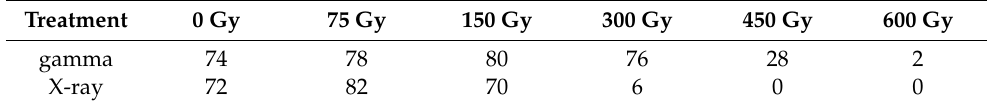
Table 1. Survival rates (%) of irradiated material after one month of hydroponic growth.